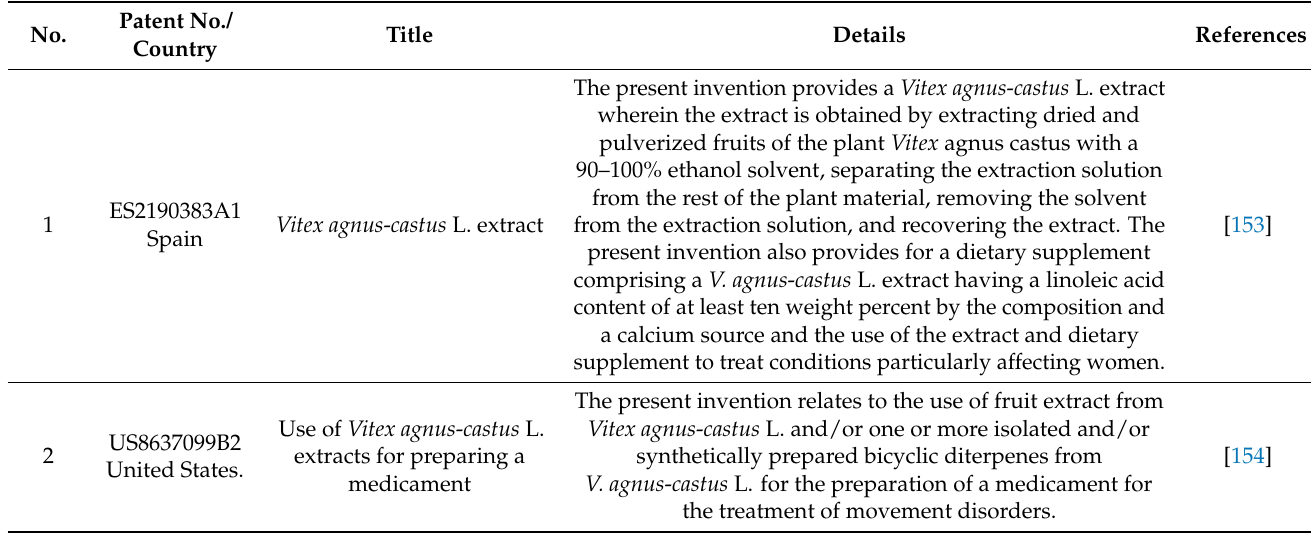
Table 4. List of patents for Vitex